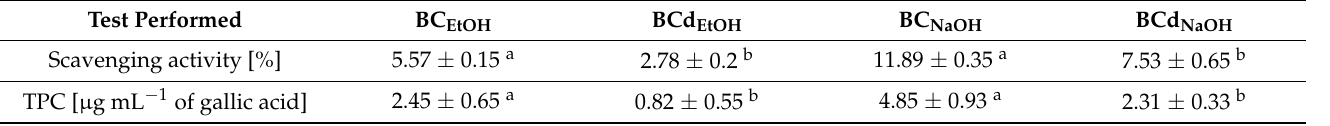
Table 3. Calculated scavenging activity of pristine and deashed biochar extracts (ethanolic